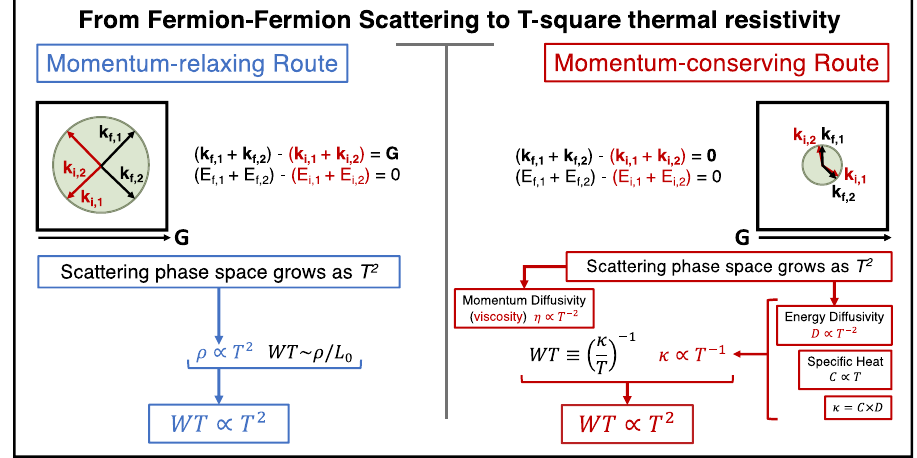
Fig. 1 Two routes towards T 2 thermal resistivity. T -square thermal resistivity in a Fermi liquid can arise in two distinct pictures of transport. The momentum-relaxing picture (left) is the one commonly used in metals. Because of the presence of a lattice, Umklapp collisions among electrons can occur. k i , j and E i , j respectively refer to the initial momentum and energy of electron j while k f , j and E f , j correspond to its fi nal momentum and energy. These collisions decay the momentum current because a unit vector of the reciprocal lattice G is lost during the collision. The momentum-conserving picture (right) has been applied to the fermionic quasiparticles in 3 He. We argue that it becomes relevant to metals, provided that : (i) Umklapp collisions become rare or impossible (because of the smallness of the Fermi radius) and (ii) the mean free path approaches the sample